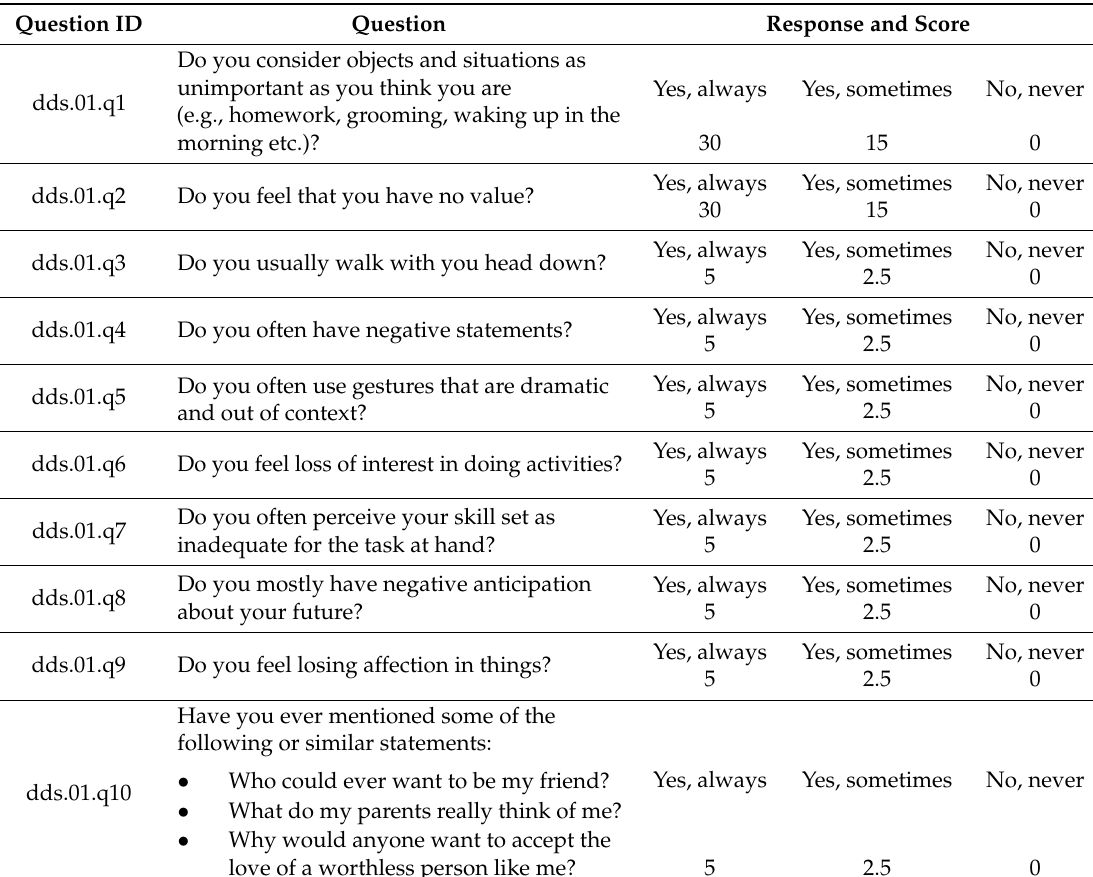
Table 3. Sample Questions for depressive disorder symptom dds.01. The dds keyword in Question ID (Identifier) represents Depressive Disorder Symptom, followed by the identifier number, followed by q, which represents Question, followed by question